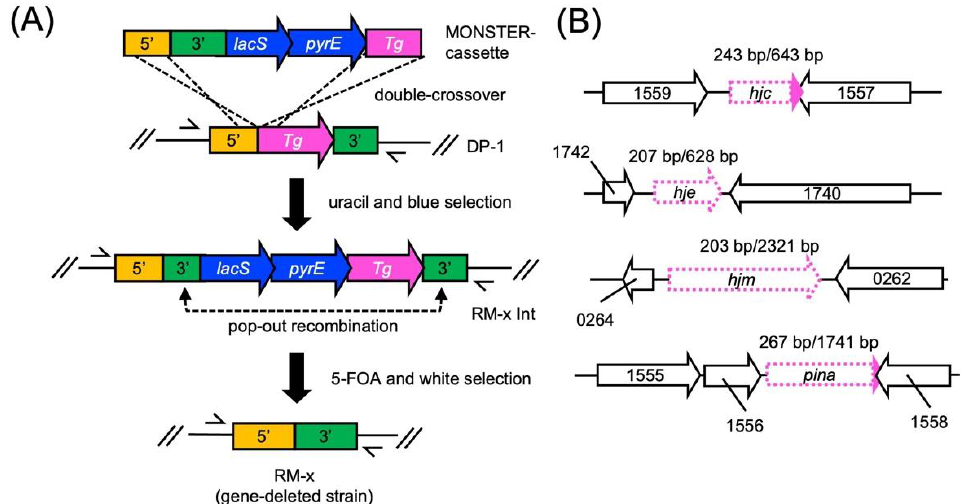
Figure 1. Construction of the gene-deleted strains using MONSTER. ( A ) Construction of genes ( hjm , pina , hjc , and/or hje ) encoding gene-deletion mutants. A plasmid-borne pyrE-lacS marker served as the PCR template, which attached S. acidocaldarius chromosomal sequences (5 ′ , 3 ′ , and partial sequences of target genes at the 5 ′ ends of the primers) to the ends of the selectable dual marker. After one-step construction, the MONSTER cassette was electroporated into strain DP-1. A double crossover between the MONSTER cassette and the chromosome at the 5 ′ and Tg regions results in the pyrE-lacS marker and 3 ′ region insertion at the target gene locus. The resulting uracil prototroph transformants that exhibit blue colonies can be selected on uracil-free plates. A target gene-deletion mutant with the marker removed was generated by pop-out recombination at two duplicated 3 ′ regions, which can be selected by 5-FOA counterselection in combination with X-gal staining. Arrows show the positions of the outer prime sets. ( B ) Setting deletion regions of the target genes. Magenta arrows indicate the target genes. The white region (dotted line) in magenta arrows indicates the locus of the deleted regions. The number above the target genes (magenta) indicates the length (bp) of the deleted sequence and whole sequence. The number in arrows indicates the gene number of Sac.